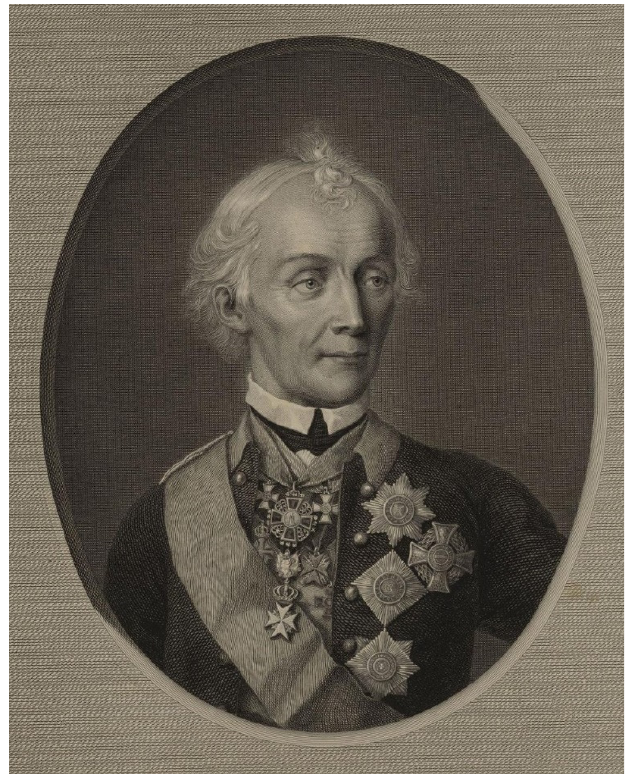
Figure 20. Nikolai Utkin, after Johann Heinrich Schmidt. Suvorov , 1818.